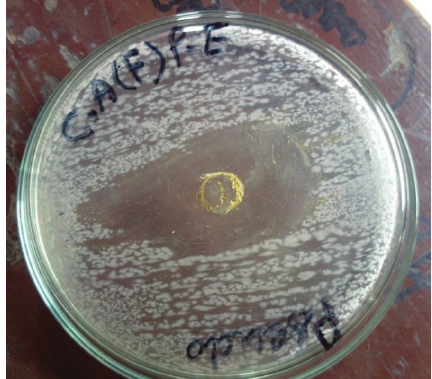
Figure 23: Zone of inhibition of petroleum ether extract of fruit of C. ambrosioides L. against P. aeruginosa .